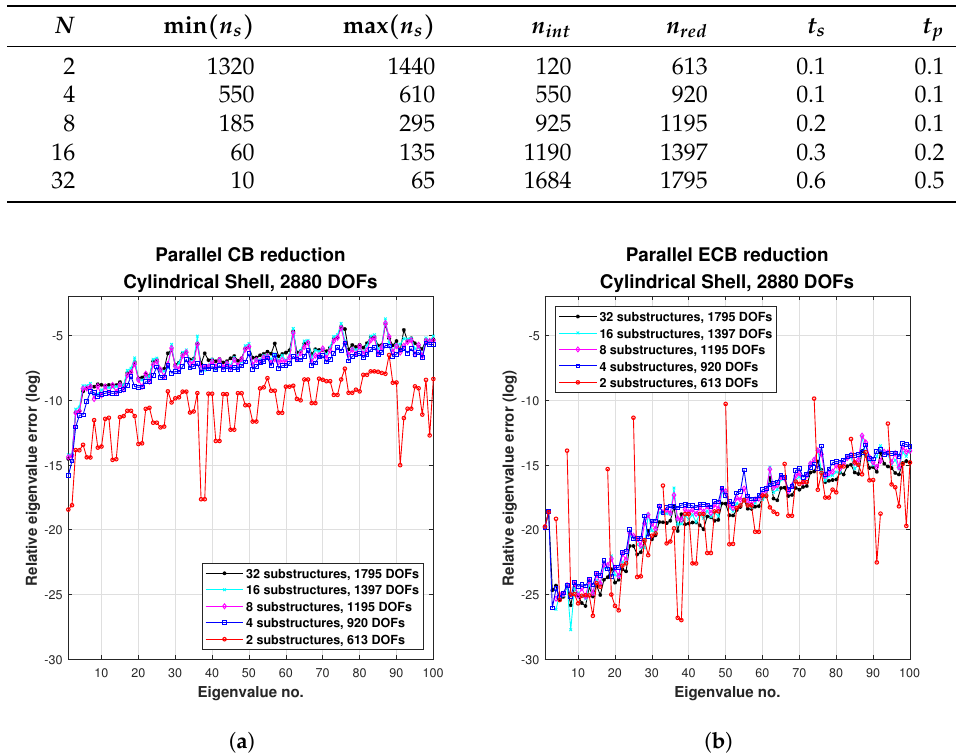
Figure 3. Comparison of reduced model accuracy, cylindrical shell. The results are obtained by ( a ) the CB method and ( b ) the ECB method,